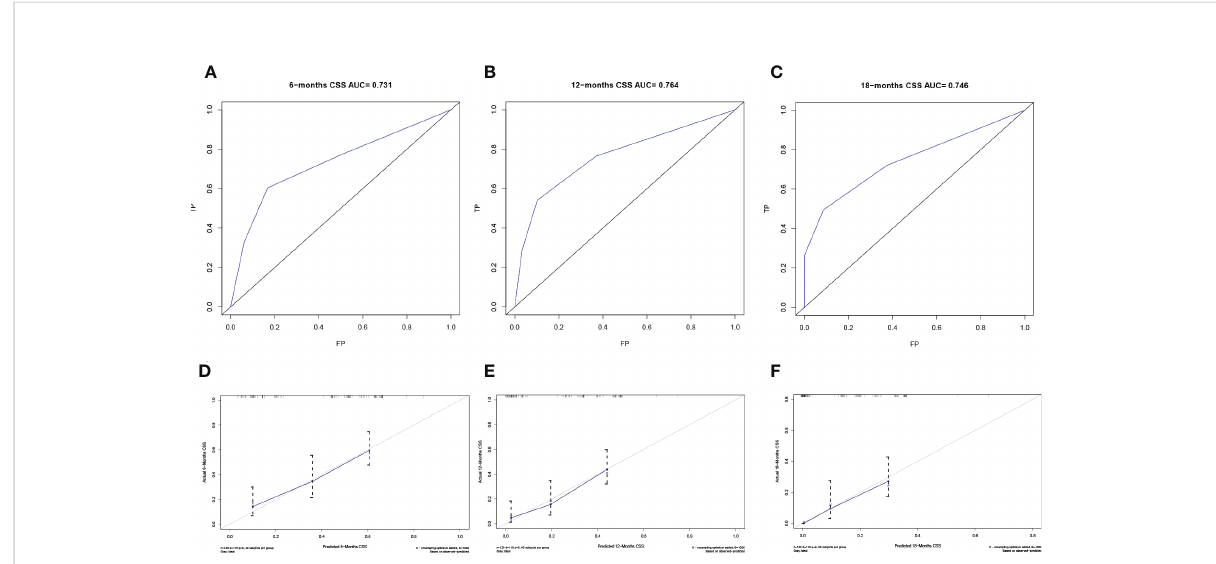
FIGURE 5 Veri fi cation of the nomogram in the validation cohort. The ROC curve (A-C) and calibration curve (D-F) of the nomogram for the 6-, 12-, and 18-month